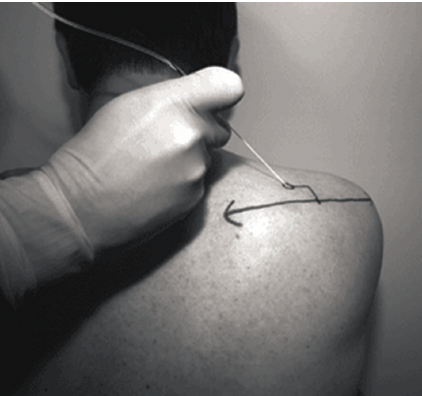
Figure 6: Meier technique for the suprascapular nerve block. Nee- dle insertion is 2cm cephalad and 2cm medial to the midpoint of a line connecting the lateral acromion and medial border of the spine of the scapula. The needle is angled 45 ◦ in the coronal plane, with 30 ◦ of ventral inclination (Price [3]). (Reprinted with